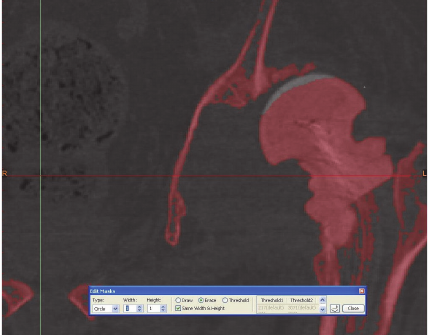
Figure 3: 3D pelvic image created from the CT scan using Materi- alise MIMICS 14.12.